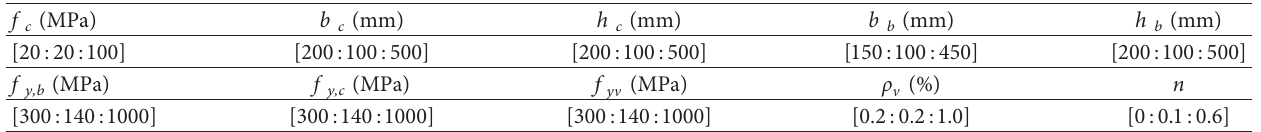
Figure 7: Comparisons of the predicted value/tested value for the GBRT and MCFT models. (a) GBRT results. (b) MCFT results. Table 8: Numerical ranges of input